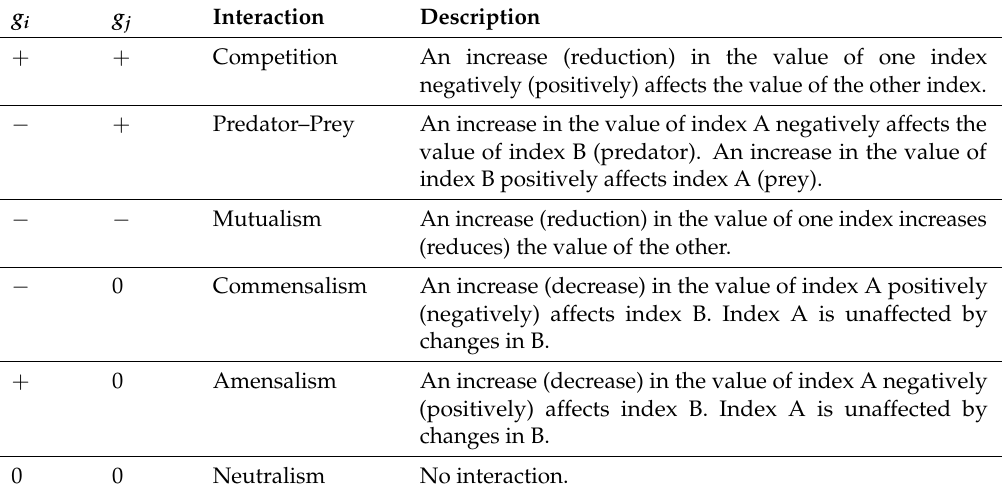
Table 1. Possible kinds of